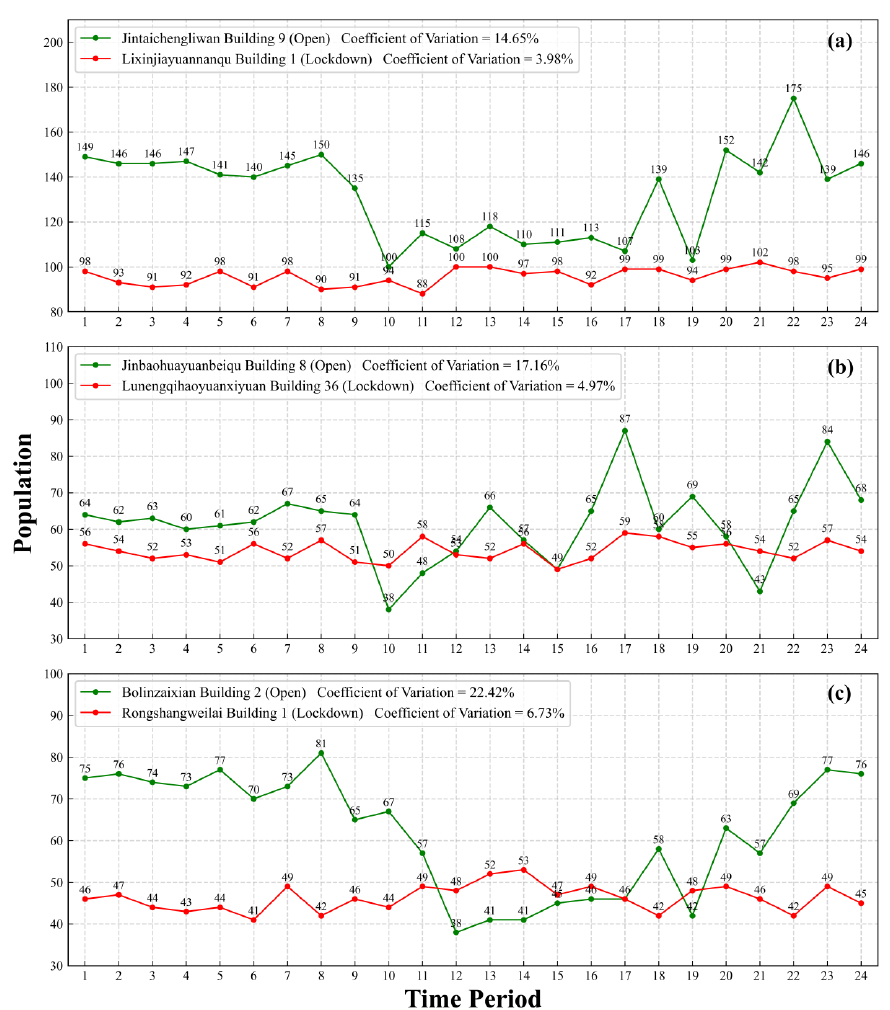
Figure 9. Population mobility over time of the three high-risk buildings and three low-risk buildings ( a – c ). The numbers in the horizontal coordinates represent each of the 24 time periods of the day (i.e., 0:00–1:00, 1:00–2:00, 2:00–3:00, 3:00–4:00,